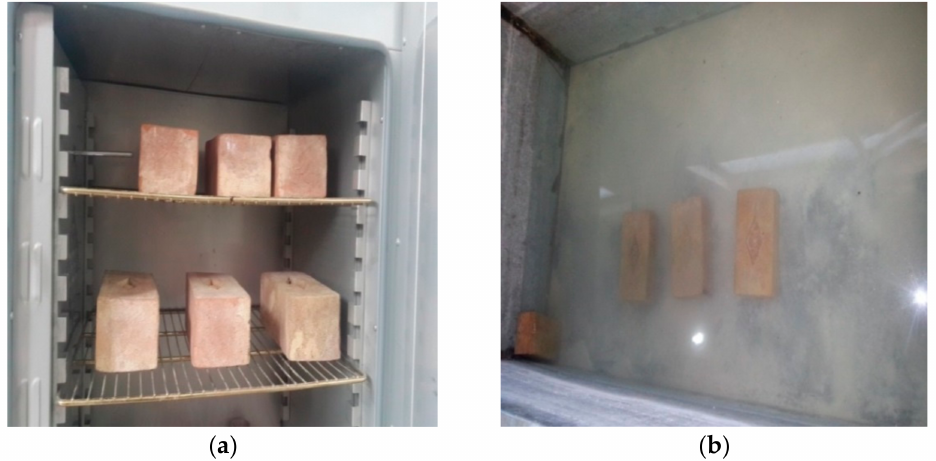
Figure 4. Water absorption test: ( a ) drying the samples in the oven, and ( b ) soaking the samples in